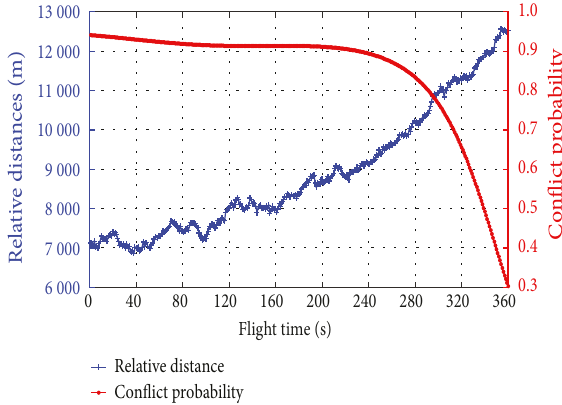
Figure 7: A pair of aircraft trajectories.